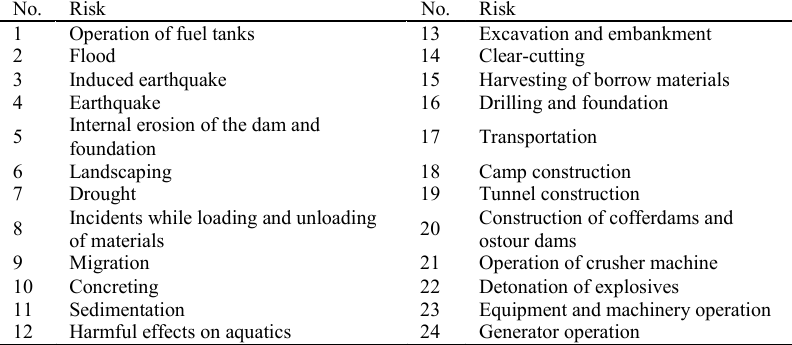
Table 9: Identified risks at constructional phase of Gavi Dam RiskNo.RiskNo.